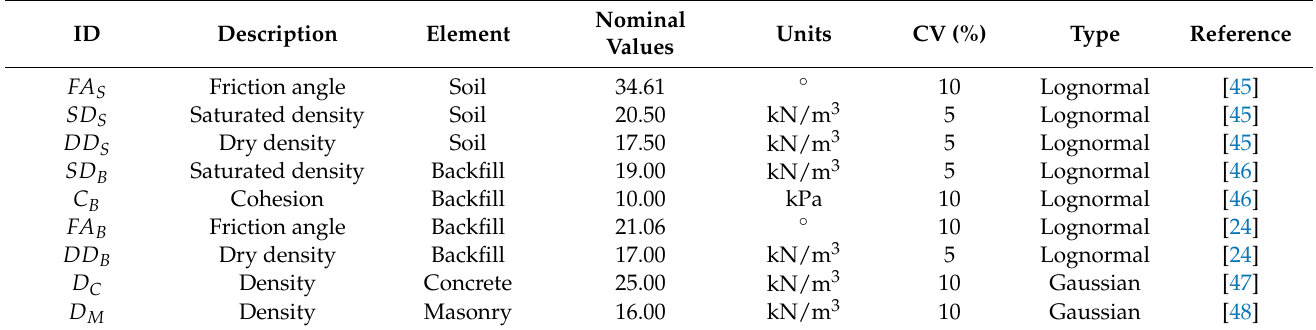
Table 2. Random variables for the reliability